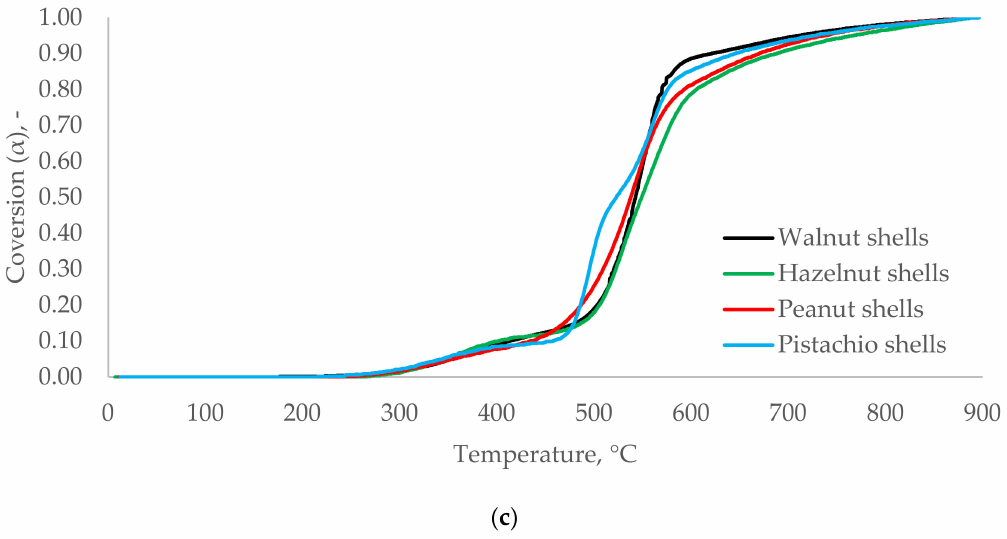
Figure 7. Conversion rates [ α (T)] for WS, HS, PES, and PIS in heating rates 5 ◦ C · min − 1 ( a ), 10 ◦ C · min − 1 ( b ), and 20 ◦ C · min − 1 ( c